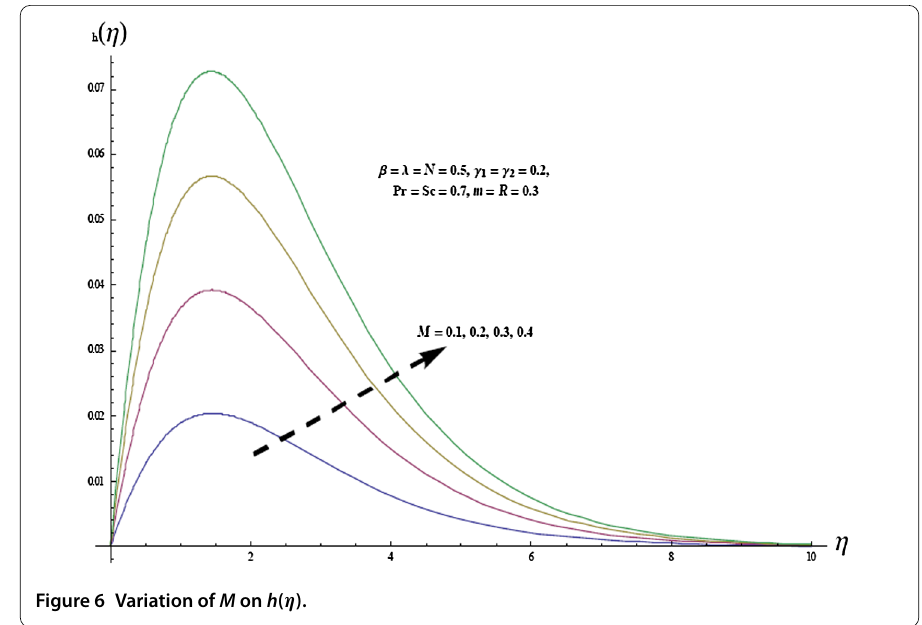
Figure 6 Variation of M on h ( η ).